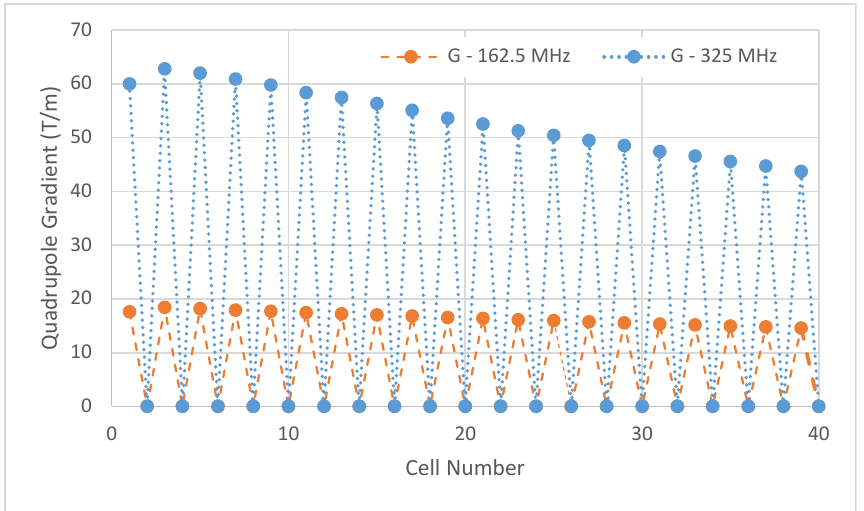
Figure 10. Quadrupole gradients of PMQs inside DTL tanks: 162.5 MHz design in yellow and 325 MHz design in blue.